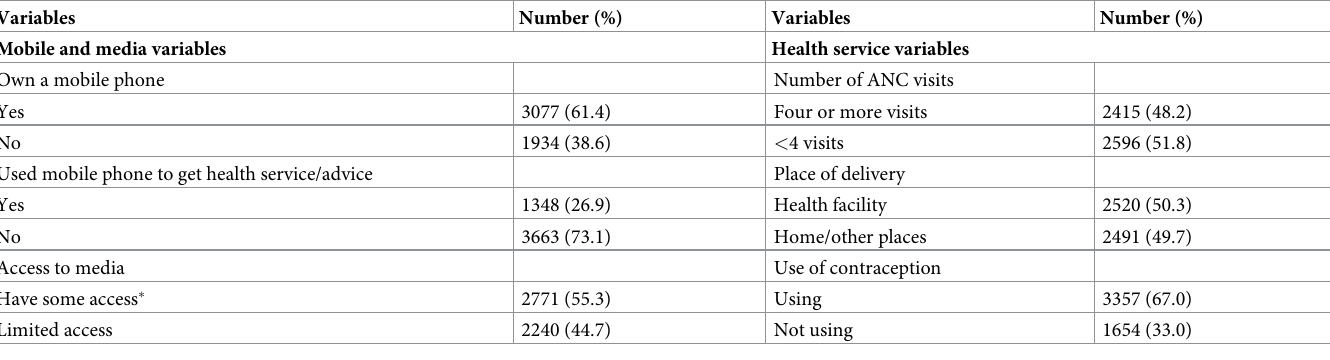
Table 2. Frequency and percentage of study